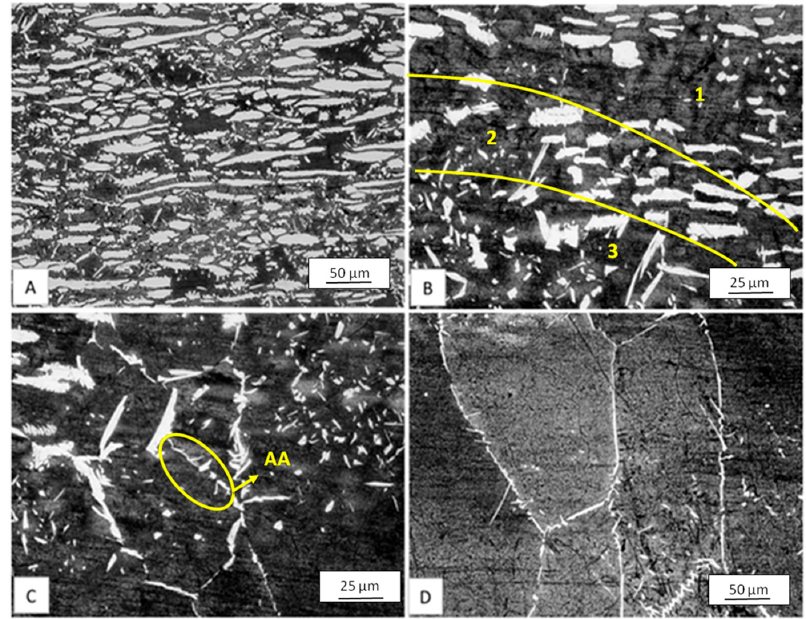
Figure 4. SAF 2304—Low heat input: ( A ): BM; ( B ): 1—BM; 2—LT-HAZ; 3—HT-HAZ; ( C ): HT-HAZ; ( D ): WM; Beraha Etching. Where: ferrite—dark/dark brown, austenite—light brown, AA— Allotriomorphic Austenite.